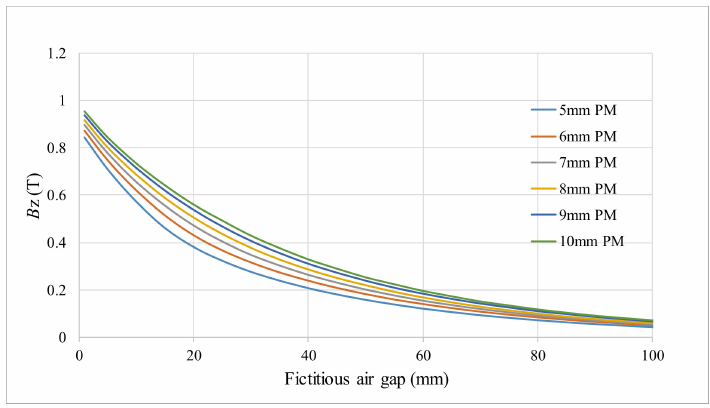
Figure 4. Influence of PM thickness on the size of B z.